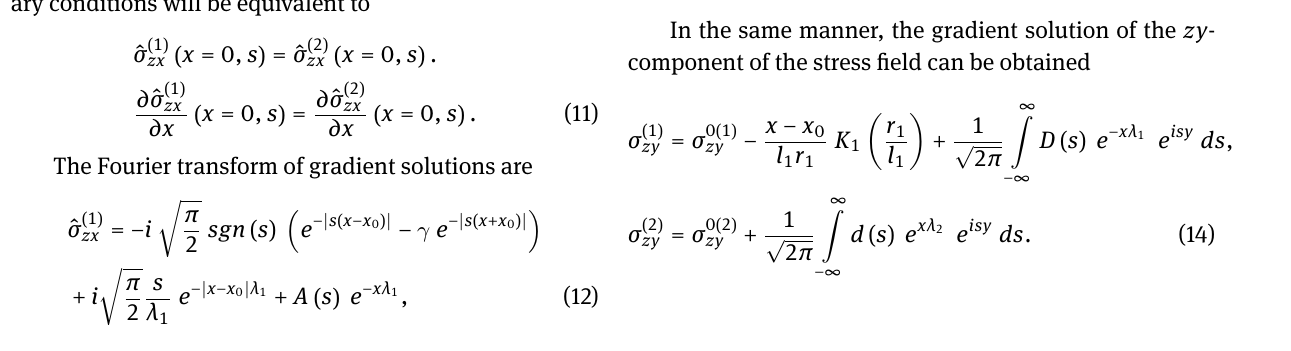
. Solid and dashed 0 / l 1 = 5 . 1 b / (2 πl 1 )